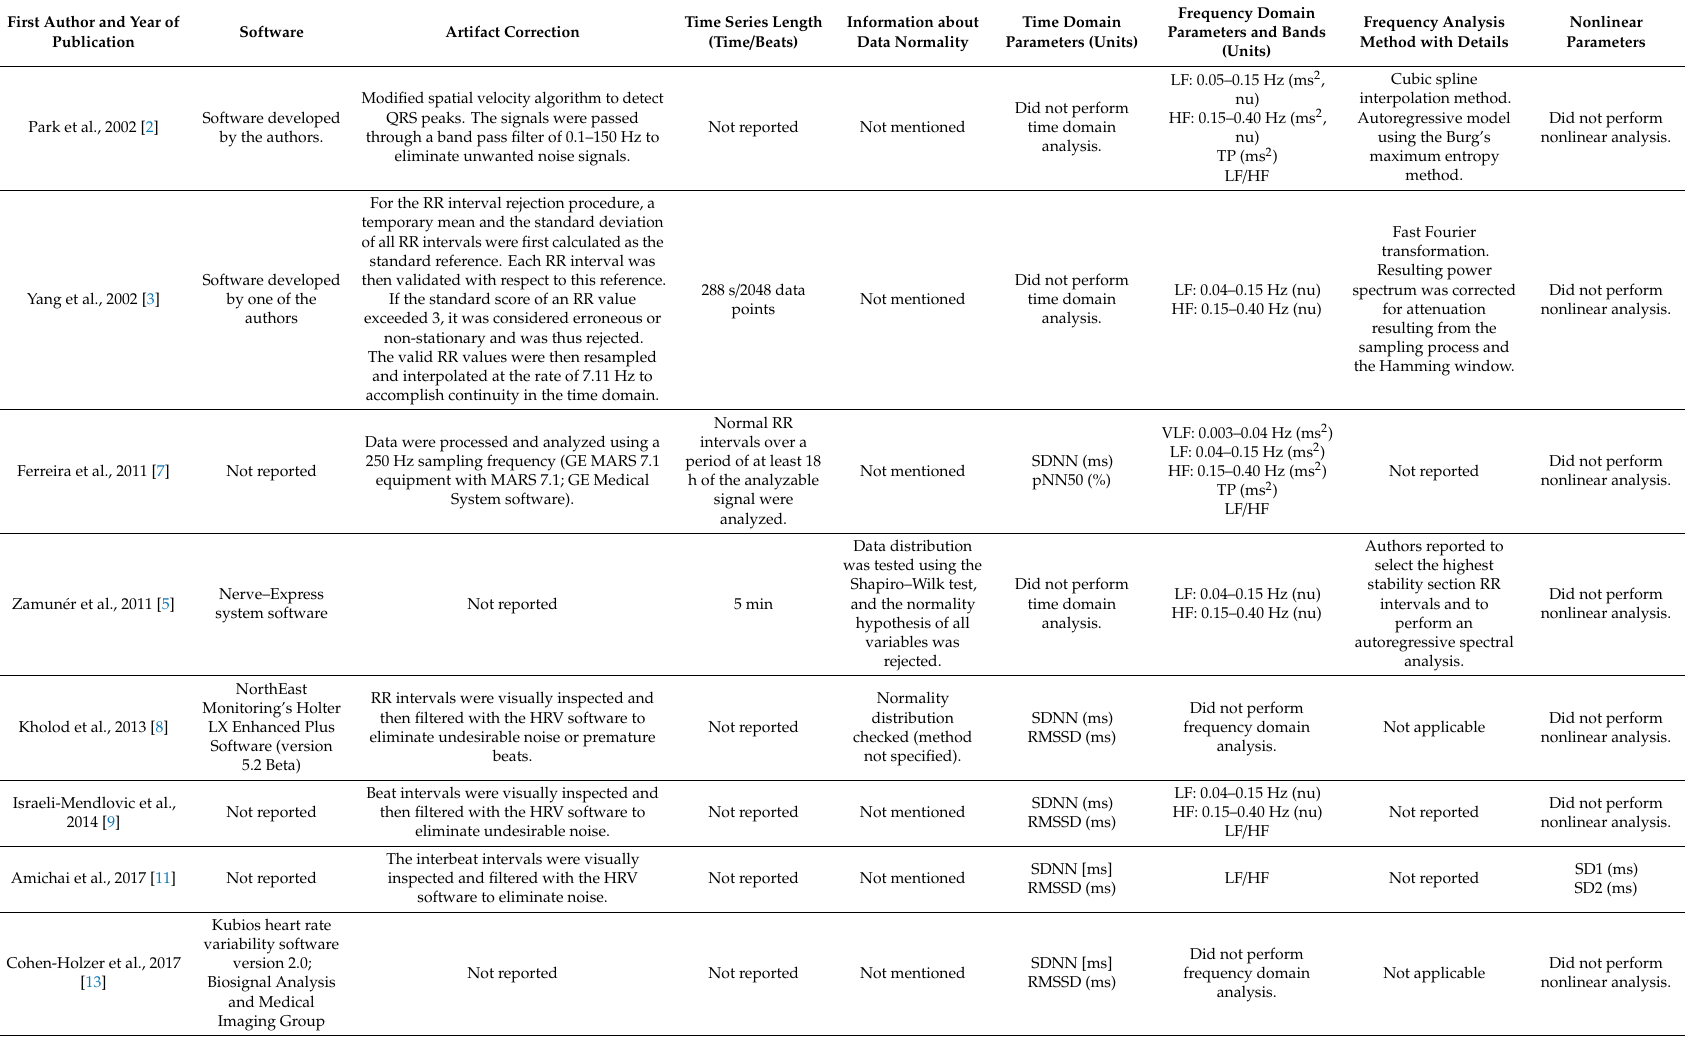
Table 2. Heart rate variability (HRV)